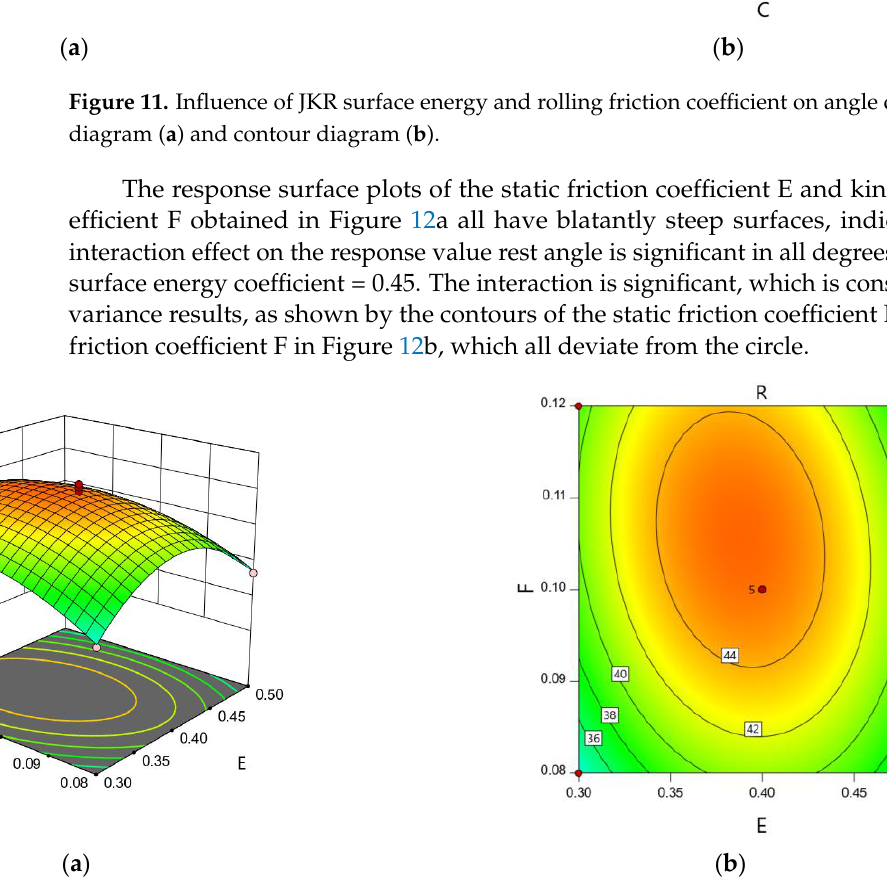
Figure 12. Surface diagram ( a ) and contour diagram ( b ) of the influence of JKR surface energy and rolling friction coefficient on repose angle.